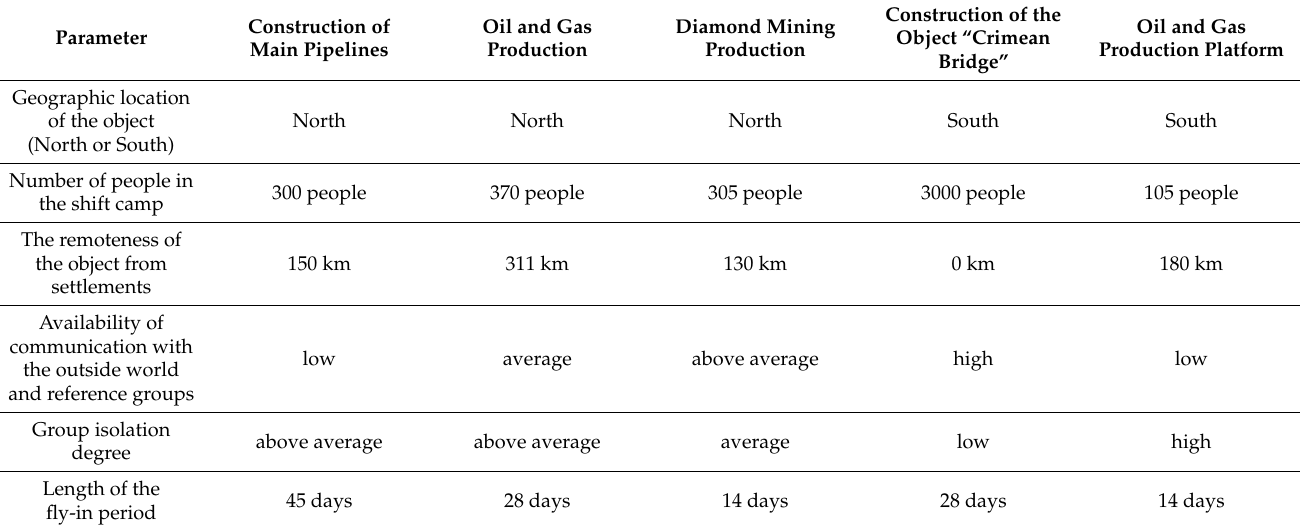
Table 1. Characteristic of samples by differential analysis